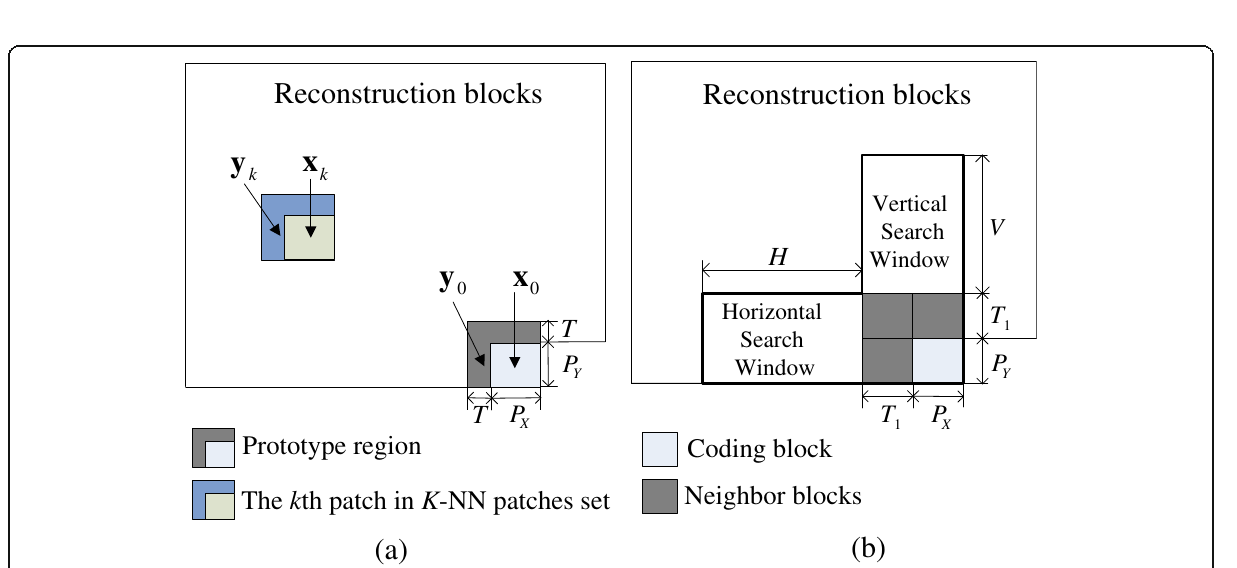
Fig. 3 Multidimensional framework. a The prototype region and one example in its K-NN set. b Searching windows used to derive the K-NN set of prototype